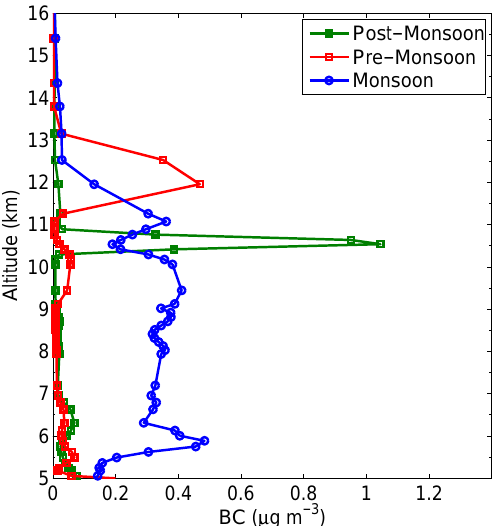
Figure 7. The model-simulated vertical profile of BC mass concen- trations (µgm − 3 ) in the vicinity of the balloon flight domain during different seasons in 2010: pre-monsoon (red line), monsoon (blue line) and post-monsoon (green line).